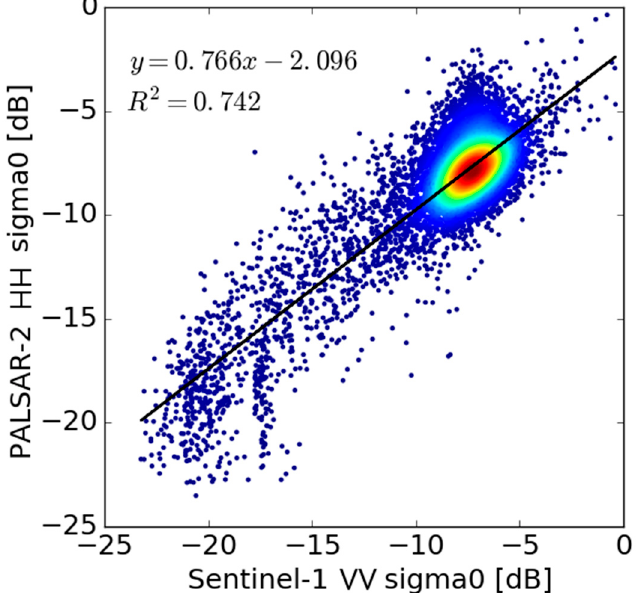
Figure 4. Linear regression analysis for Sentinel-1 and PALSAR-2 ( N = 10000). The regression line (i.e., conversion equation from Sentinel-1 to PALSAR-2) and the coefficient of determination are also shown.